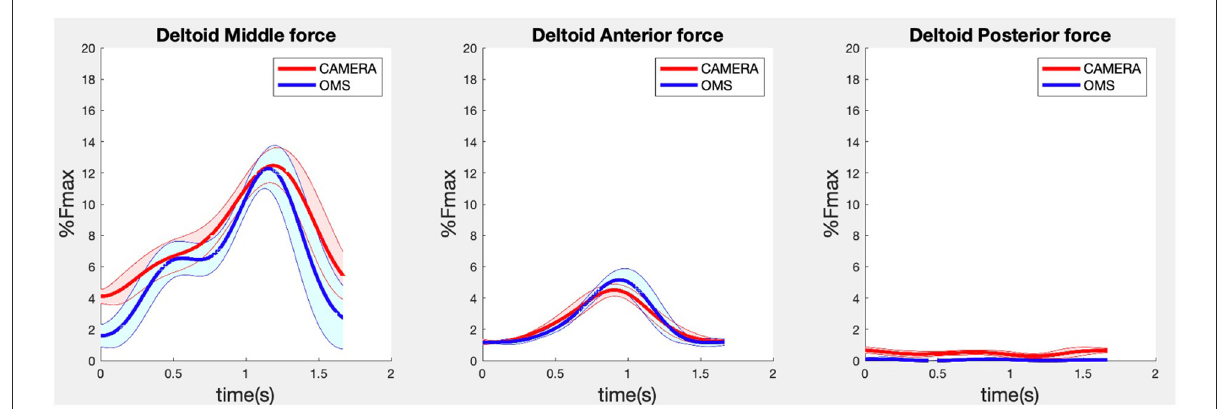
FIGURE4 Results for the middle (left), anterior (middle) and posterior (right) deltoid muscle forces during the lateral fly exercise. Results obtained from OMS (blue) and a single camera (red) are presented as mean ± 1SD (shaded) over all